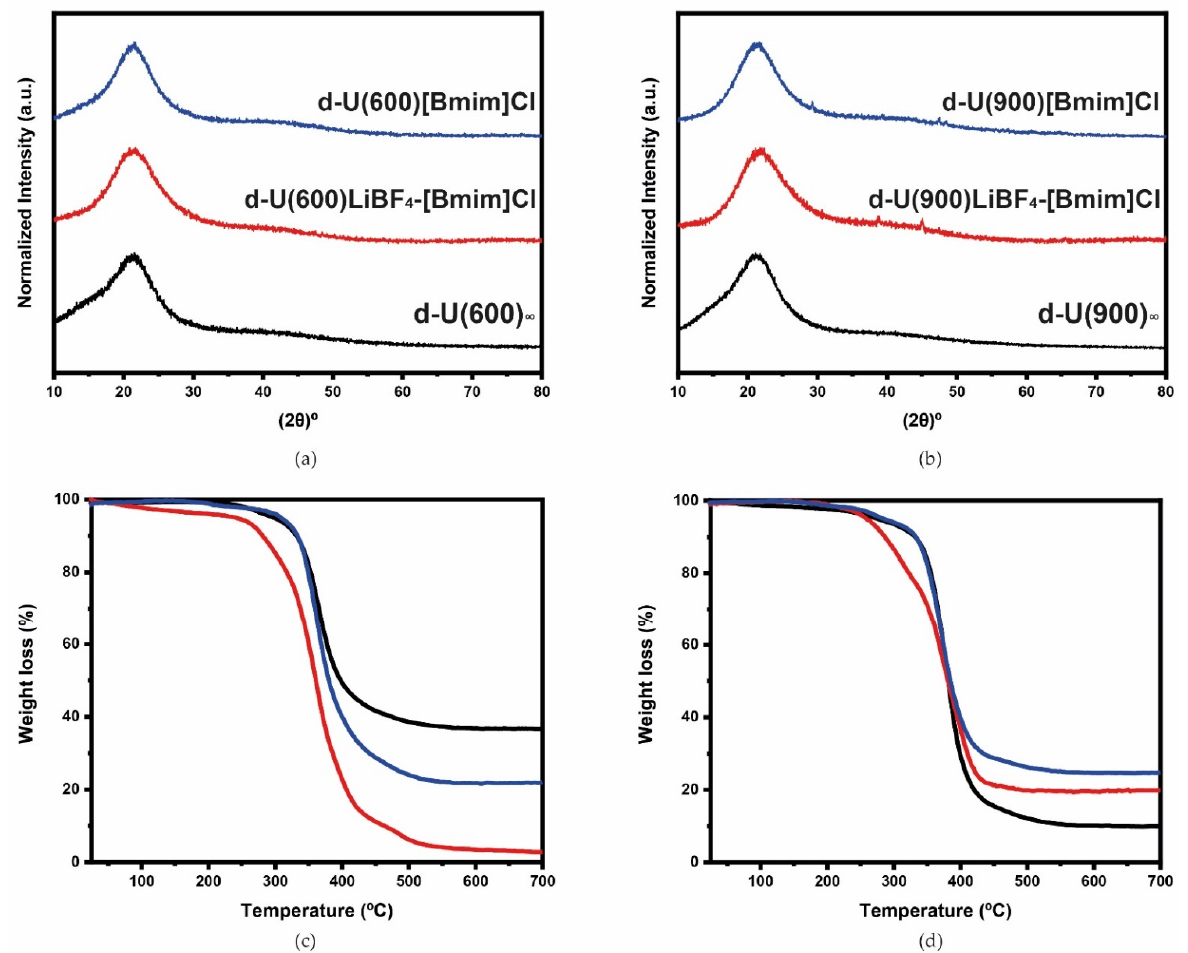
Figure 1. Diffractograms ( a , b ) and thermograms ( c , d ) of the d-U(600) and d-(900)-based electrolytes. Non-doped materials (black line), materials doped with LiBF 4 and [Bmim]Cl (red line) and materials doped solely [Bmim]Cl (blue line).